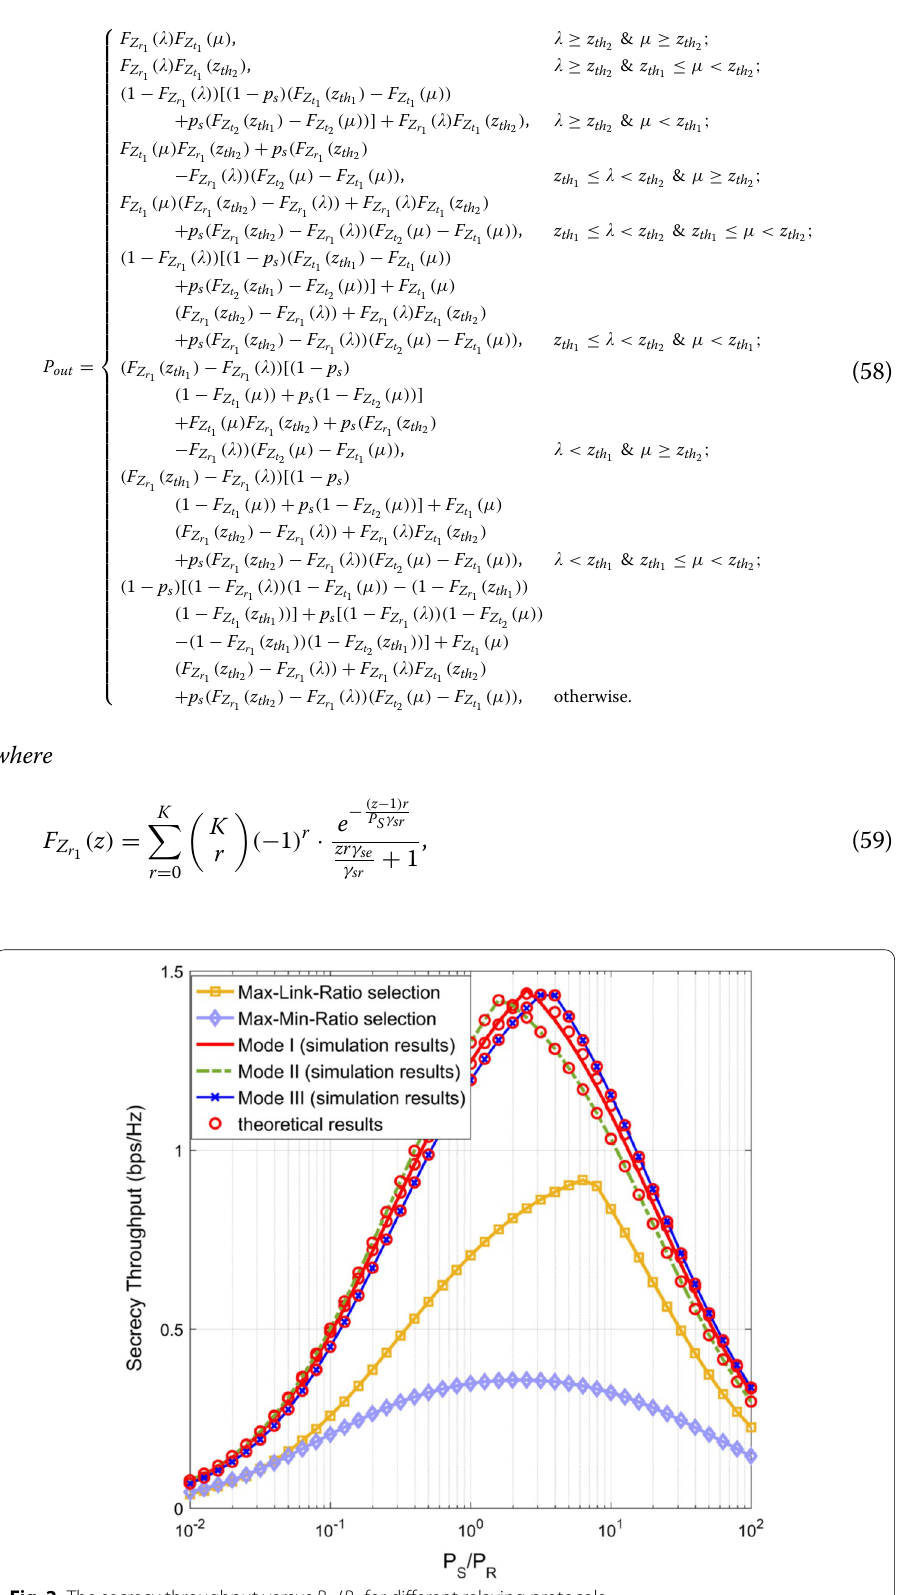
Fig. 2 The secrecy throughput versus P S / P R for different relaying